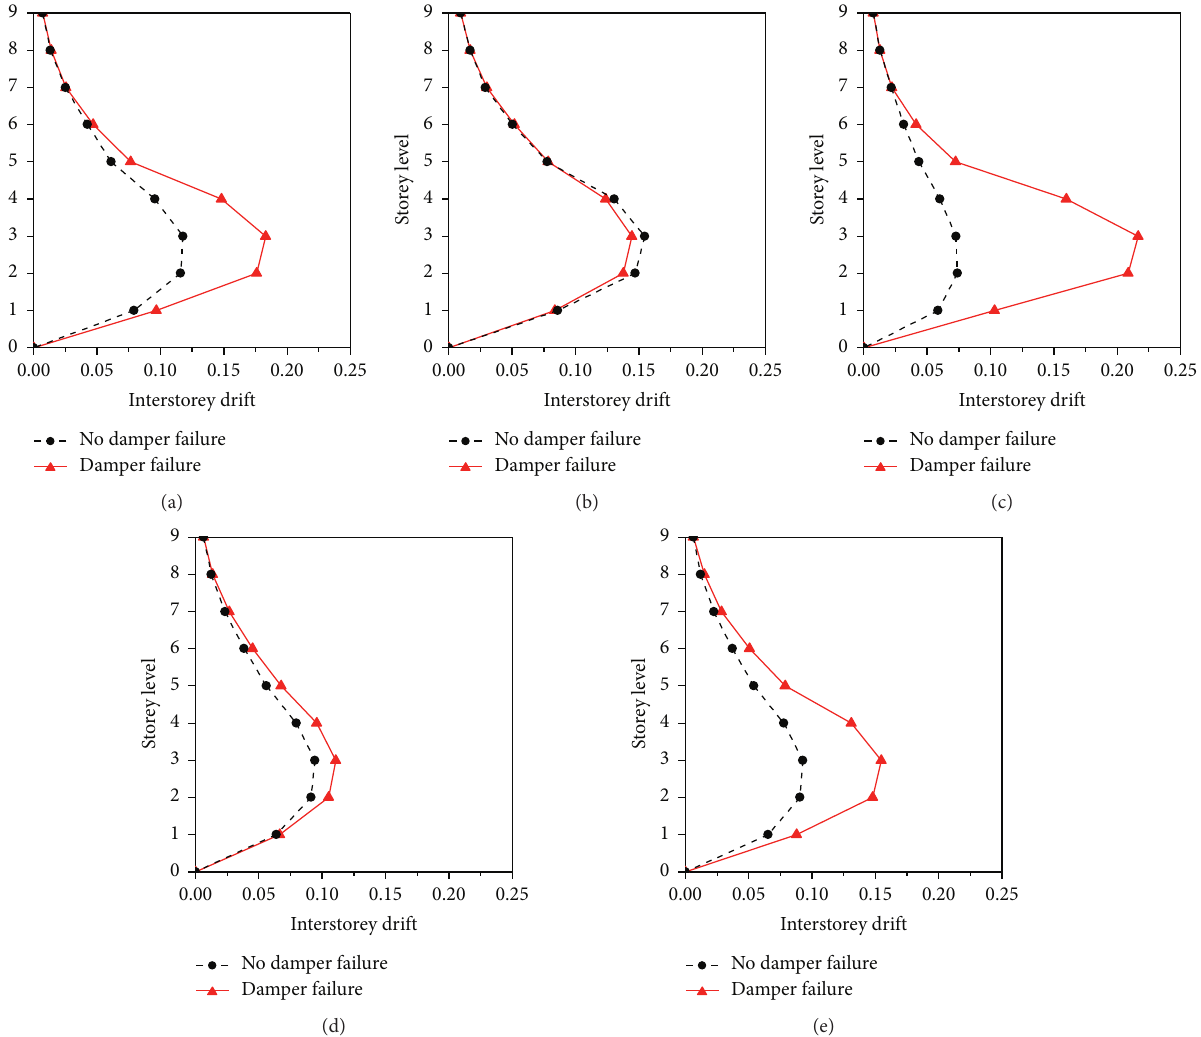
Figure 14: Maximum interstorey drift response of building-damper systems with and without damper failure. (a) Building-BRB system. (b) Building-FD system. (c) Building-SCD system. (d) Building-VD system. (e) Building-VED